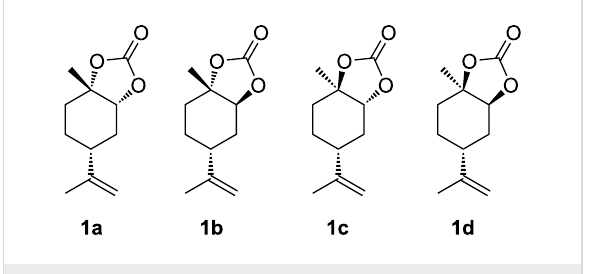
Figure 1: Diastereomers of LM5CCs, 1a – d .